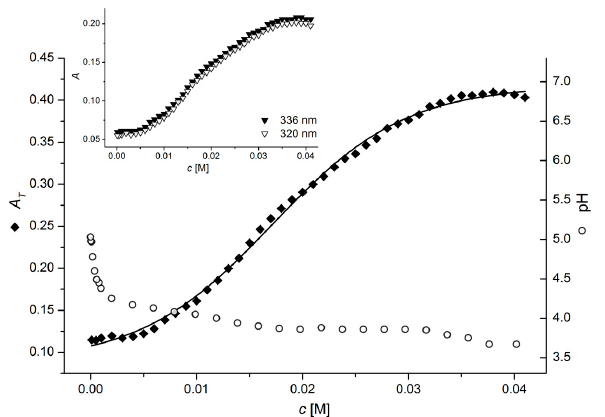
Figure 2. A T vs. concentration ( c ) profile for compound 4 in aqueous medium at 25 °C ( ◆ ); pH values vs. concentration ( c ) profile at 25 °C ( ○ ). Inset: Plots of absorbances (A) of individual pyrene peaks (at 336 and 320 nm) vs. surfactant concentration.